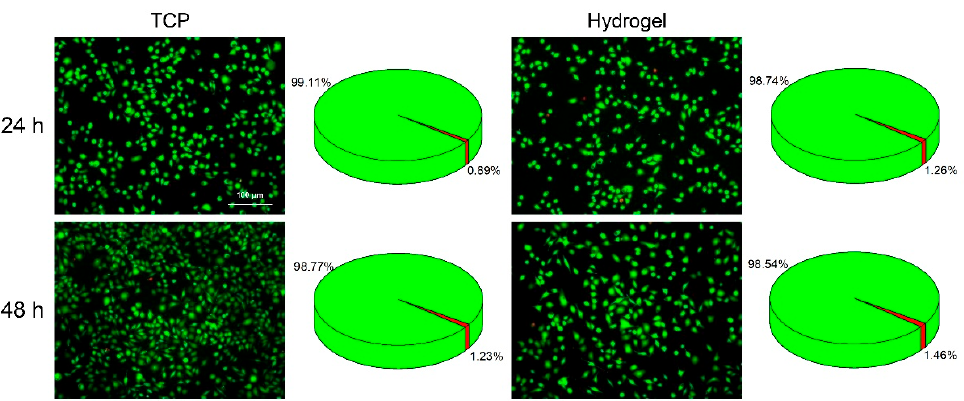
Figure 4. Live/dead staining of L929 cells that were treated with TCP or hydrogel for 24 h and 48 h.